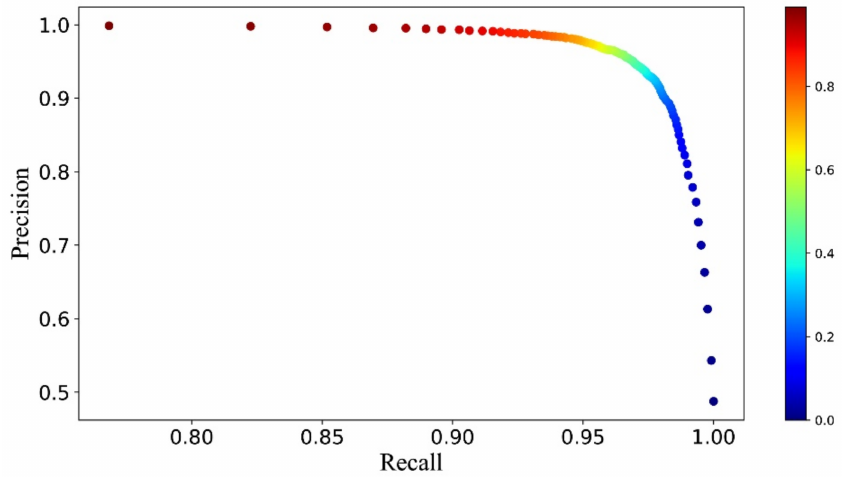
Figure 10. Precision–recall curve.